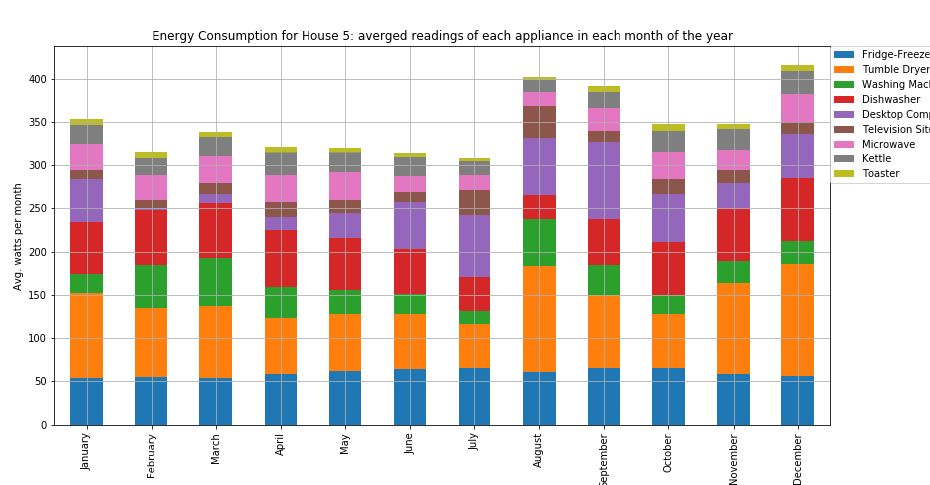
Figure A4. The average consumption per hour of home appliances for house 10 with four occupants.